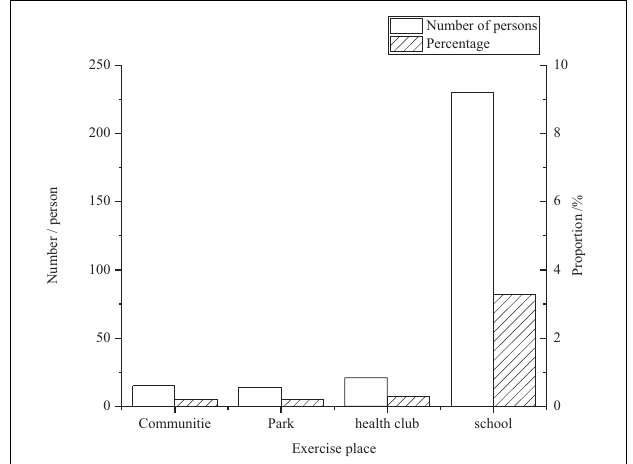
FIGURE 3 | Sites at which primary and middle school students do physical exercise.